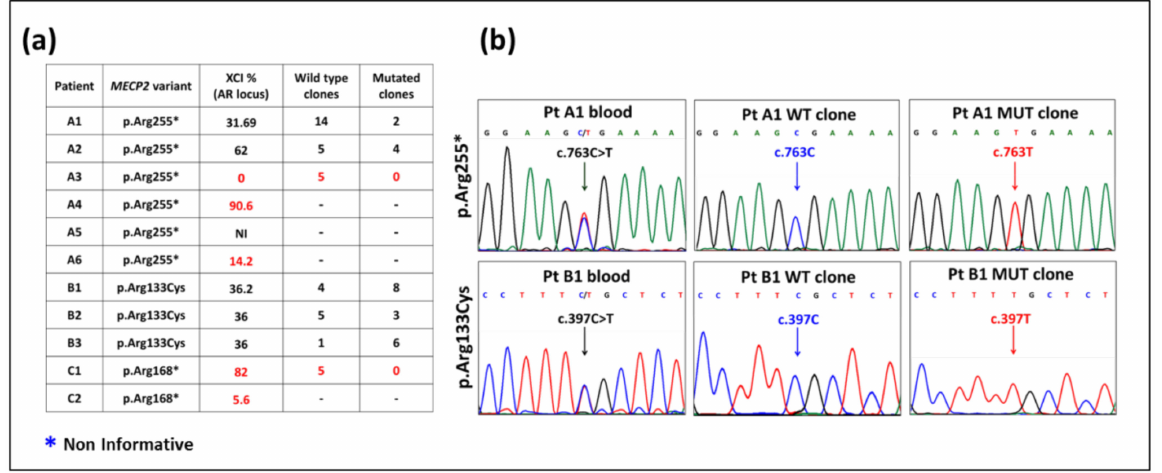
Figure 2. XCI pattern and selective expression of wild-type (WT) and pathogenic variant (MUT) allele in RTT female iPSC lines. ( a ) The table sums up XCI analyses. Patients with XCI > 80–85% or <15–20% were considered unbalanced and are highlighted by red characters. In patient A5, non-informative for the AR locus (*), XCI was investigated at DXS6673E locus (XCI = 13.5%). The number of wild-type and mutant clones obtained are reported respectively in the fourth and fifth column of the table. ( b ) Electropherograms of cDNA sequences from p.Arg255* and p.Arg133Cys RTT girls displaying biallelic expression of MECP2 allele in the blood and monoallelic expression of WT or MUT allele in the iPSC isogenic